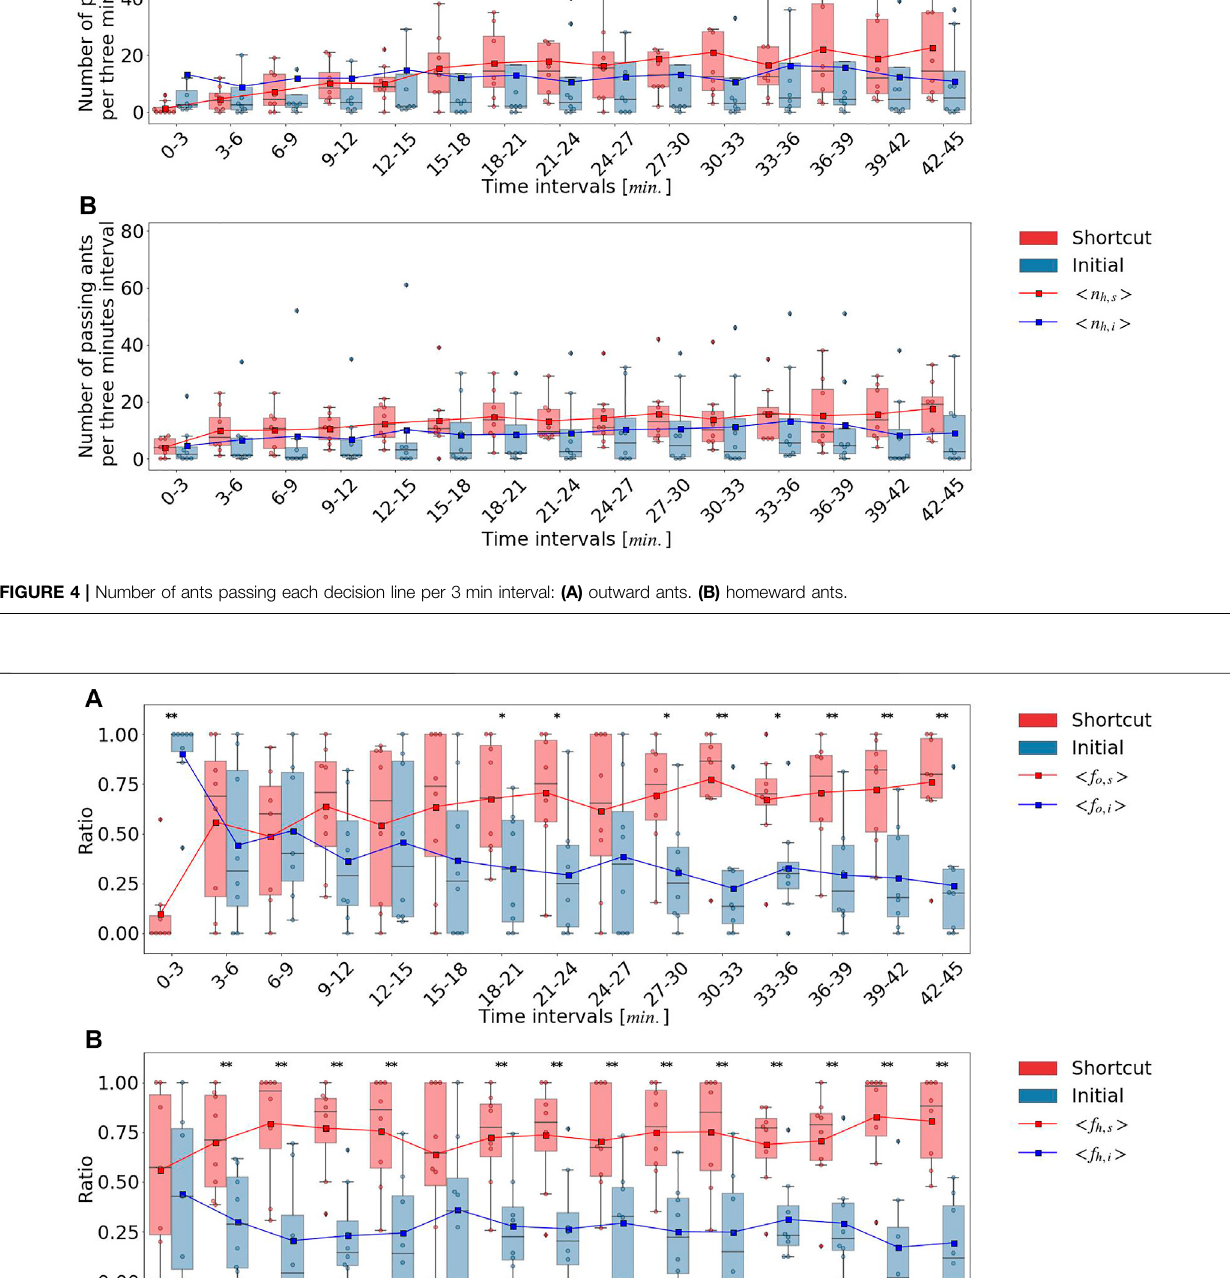
Frontiers in Physics |